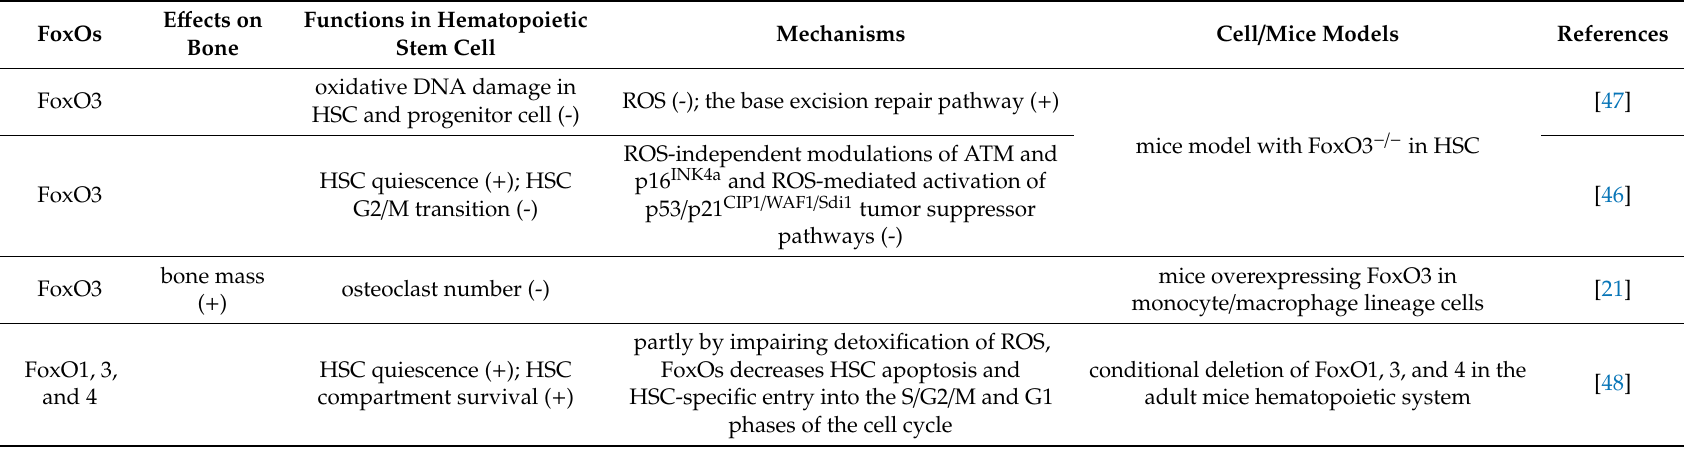
Table 3. Bone metabolism regulatory functions of FoxO transcription factors in hematopoietic stem